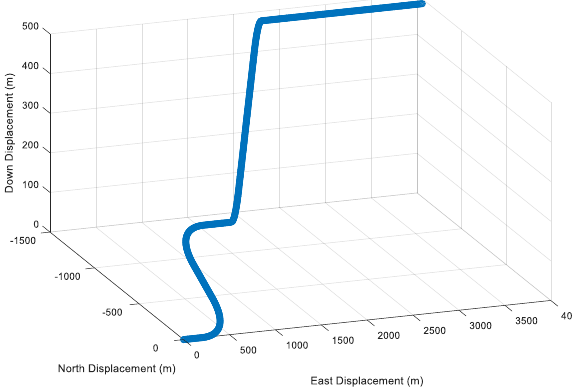
Figure 3. Unmanned aerial vehicle (UAV) trajectory in the simulation tests.